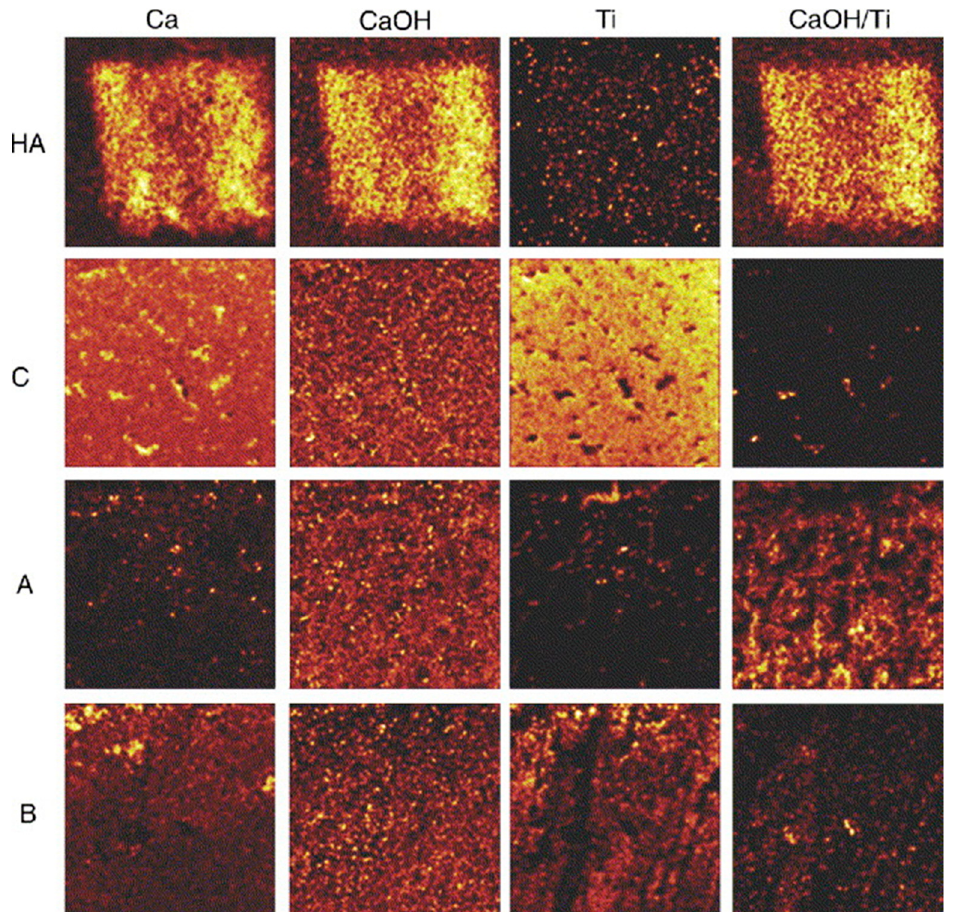
Figure 2. Time-of-Flight Secondary Ion Mass Spectrometry (TOF-SIMS) images showing the secondary ion distributions for the hydroxyapatite control (HA), not anodized titanium control after implantation (C), and the implanted porous surfaces A and B. The figure shows the results for Ca 2+ , CaOH, Ti, and a normalization image calculated from CaOH and Ti images of the sample. All images were normalized to the total ion count. The field of view is 200 µm × 200 µm, except for HA, which is 500 µm × 500 µm. (Reprinted with permission from [47], Elsevier 2006 copyright n. 4710120857878).